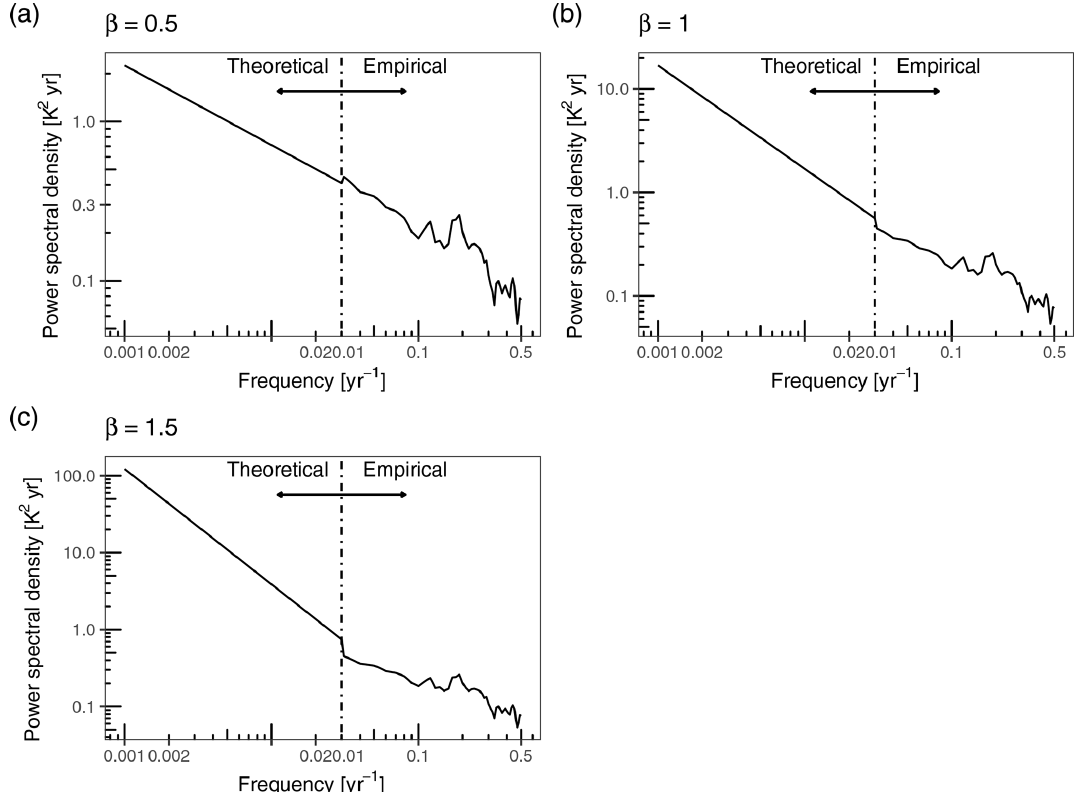
Figure A1. Spliced empirical and power-law power spectrum of ocean temperature (0–120m water depth) for 20 ◦ N latitude with slopes of 0.5, 1, and 1.5 for the low-frequency power-law region of the spectrum.